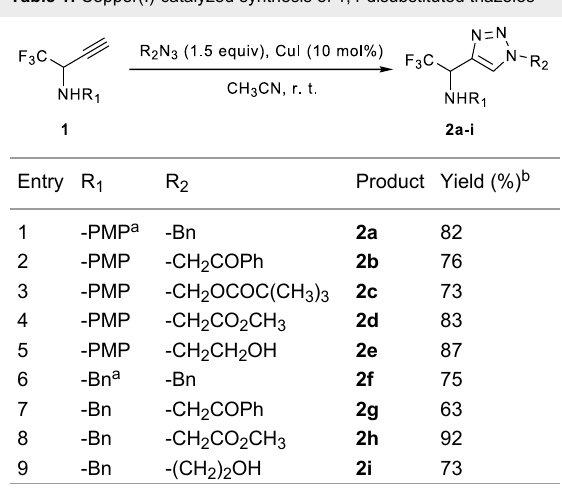
Table 1: Copper(I)-catalyzed synthesis of 1,4-disubstituted triazoles